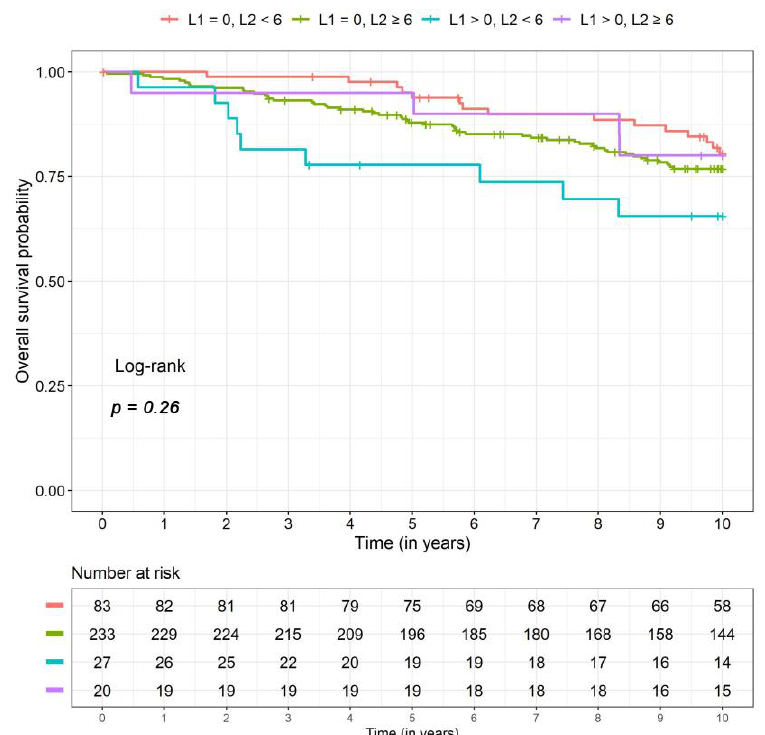
Figure 6. Kaplan–Meier curves for the four di ff erent combinations of PIWI-like 1 IRS (L1) and PIWI-like Figure 4. Kaplan–Meier curves for the four different combinations of PIWI-like 1 IRS (L1) and PIWI- 2 IRS (L2) for overall like 2 IRS (L2) for overall survival.